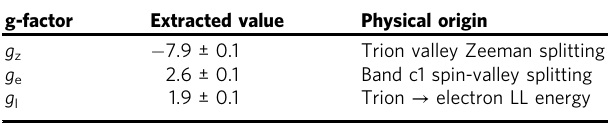
Table 2 Summary of extracted g-factors g-factor Extracted